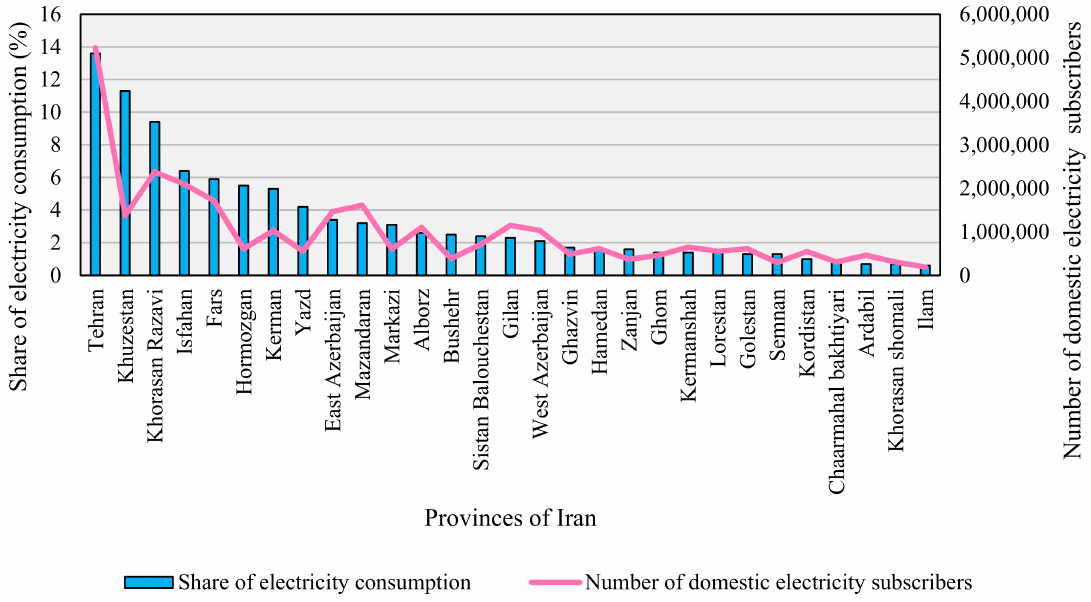
Figure 22. The comparison between the share of electricity use of provinces in the total consumption of the country vs. the number of household electricity subscribers in